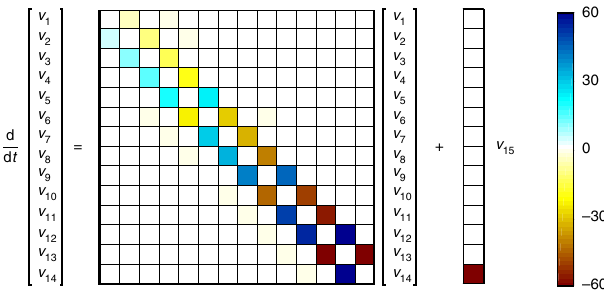
Fig. 2 The regression model obtained for the Lorenz system is sparse, having a dominant off-diagonal structure. This HAVOK model is highly structured, with skew symmetric entries that are nearly integer multiples of fi ve; this fascinating structure is explored more in Supplementary Note